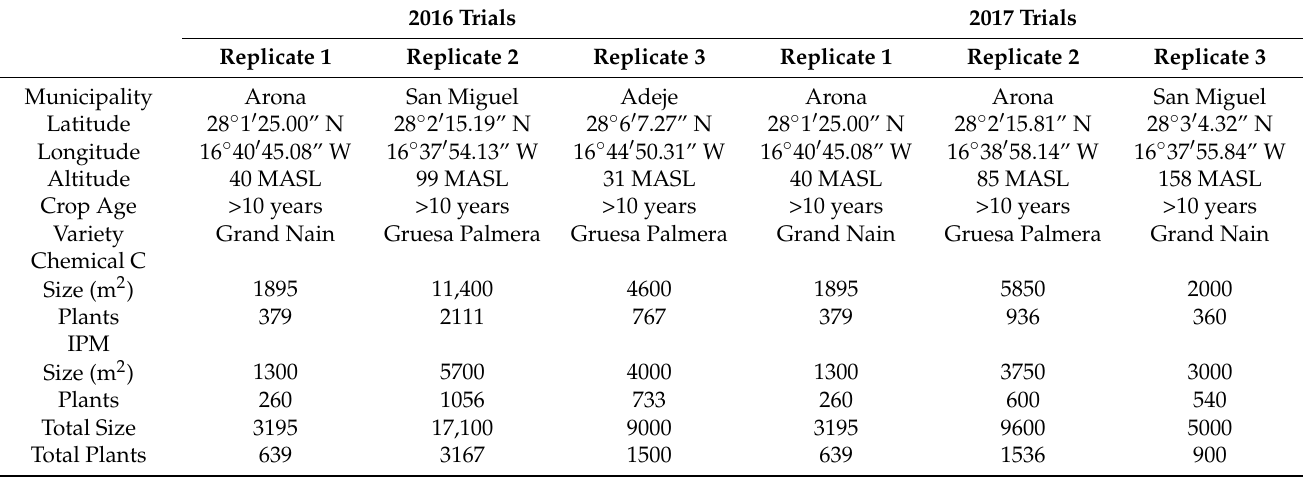
Table 1. Characteristics of the experimental